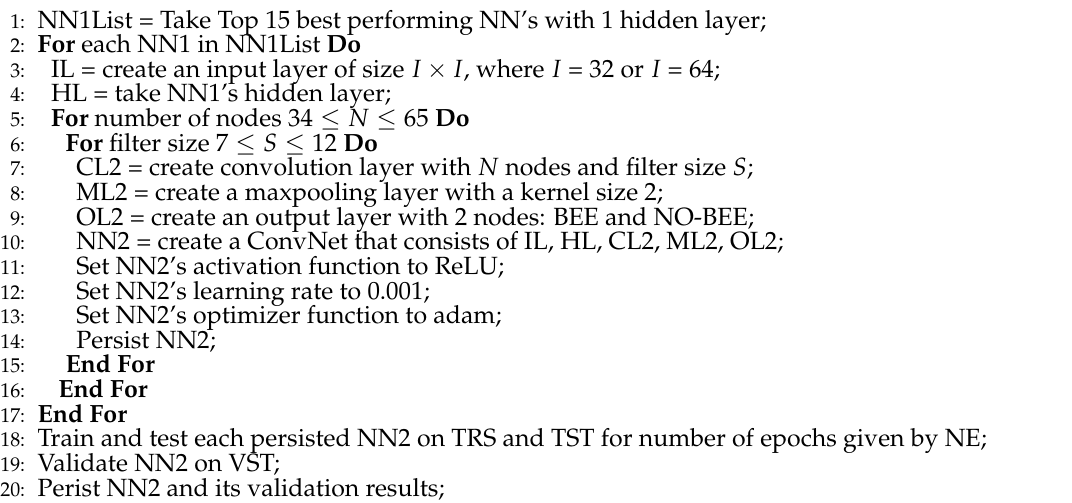
Algorithm 3 TrainGen2ConvNets (TrainSet TRS, TestSet TTS, ValidSet VST, and int